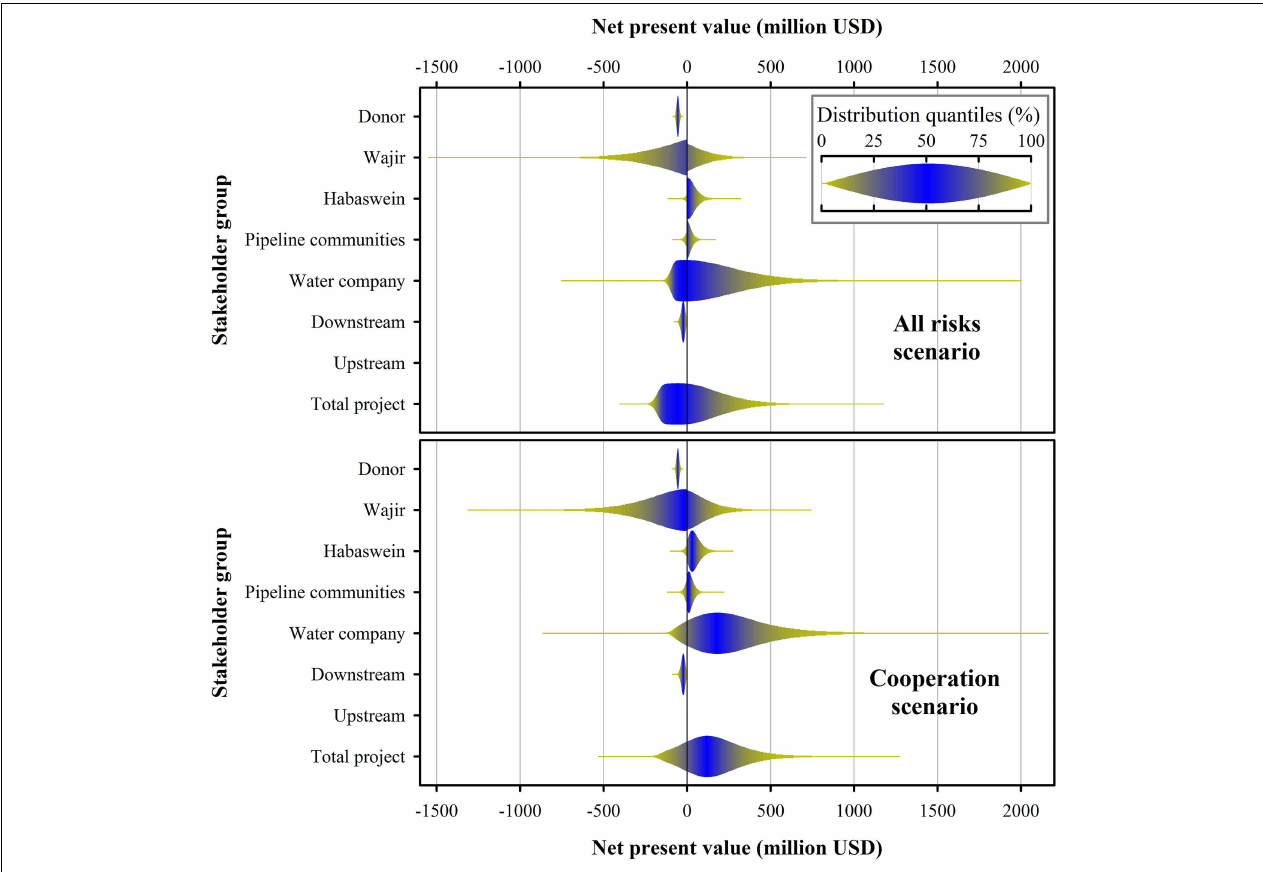
( Figure 8 ). Number and value of disease treatments rendered unnecessary, as well as the discount rate applied for the resi- dents of Habaswein followed in terms of importance. The risk of losses due to poor project design, the future water price and the number of water users were also identified as key